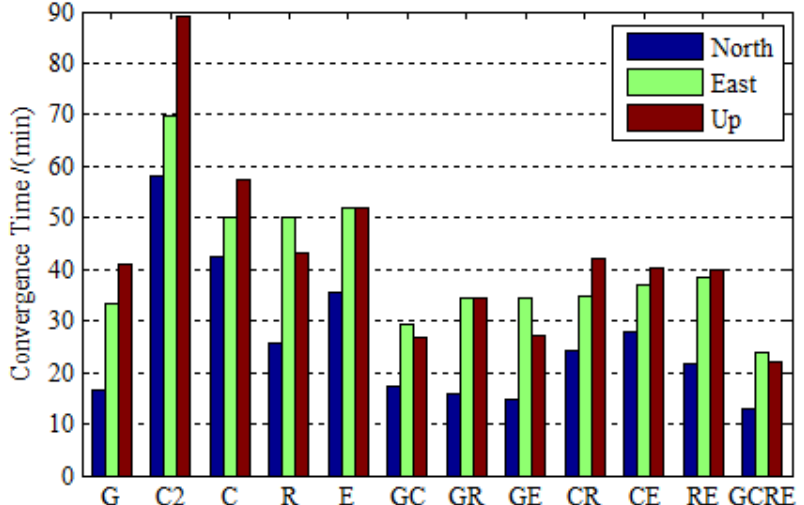
Figure 6. The convergence time for GPS-only, BDS-2-only, BDS-2 / BDS-3, GLONASS-only, Galileo-only, GPS / BDS-2 / BDS-3, GPS / GLONASS, GPS / Galileo, BDS-2 / BDS-3 / GLONASS, BDS-2 / BDS-3 / Galileo, GLONASS / Galileo, and GPS / BDS-2 / BDS-3 / GLONASS / Galileo static PPP processing using real observation data collected at 16 stations over 30